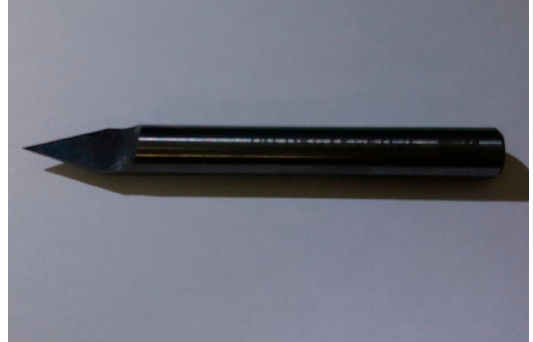
Figure 1. Tungsten steel microshaper. The microshaper in mounted on CNC machine to machine the microlens.